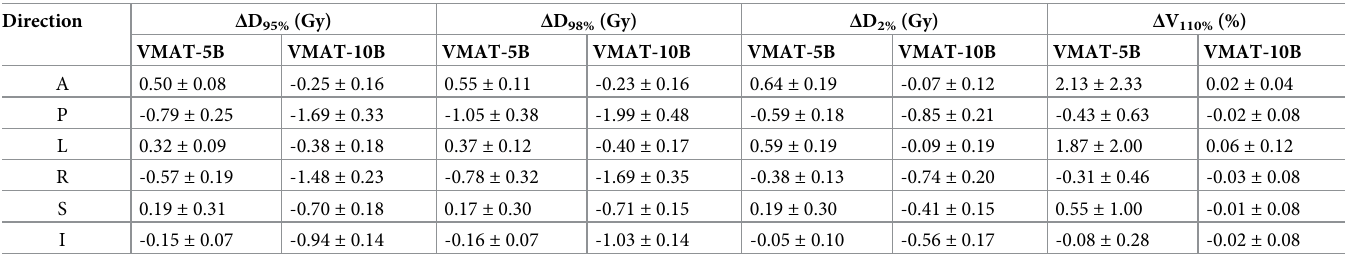
Table 3. Absolute differences in CTV between the perturbed and original plans.